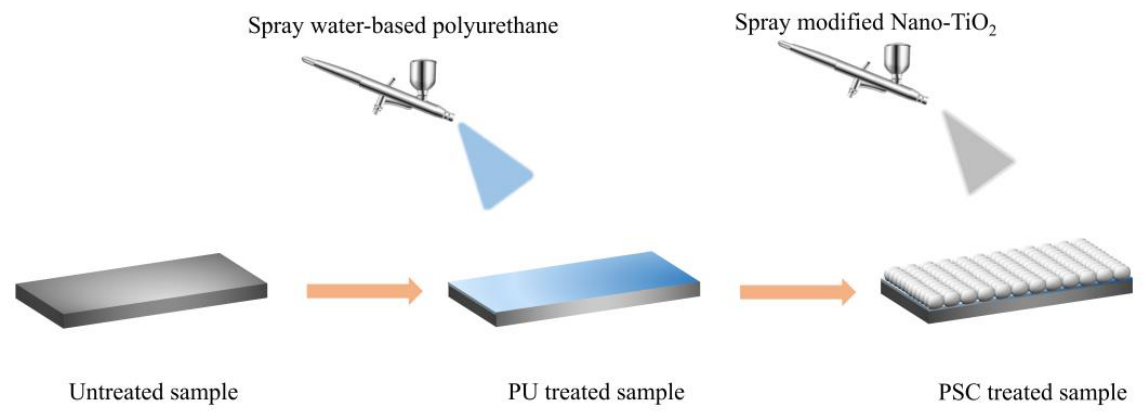
Figure 1. Schematic diagram of the preparation process .